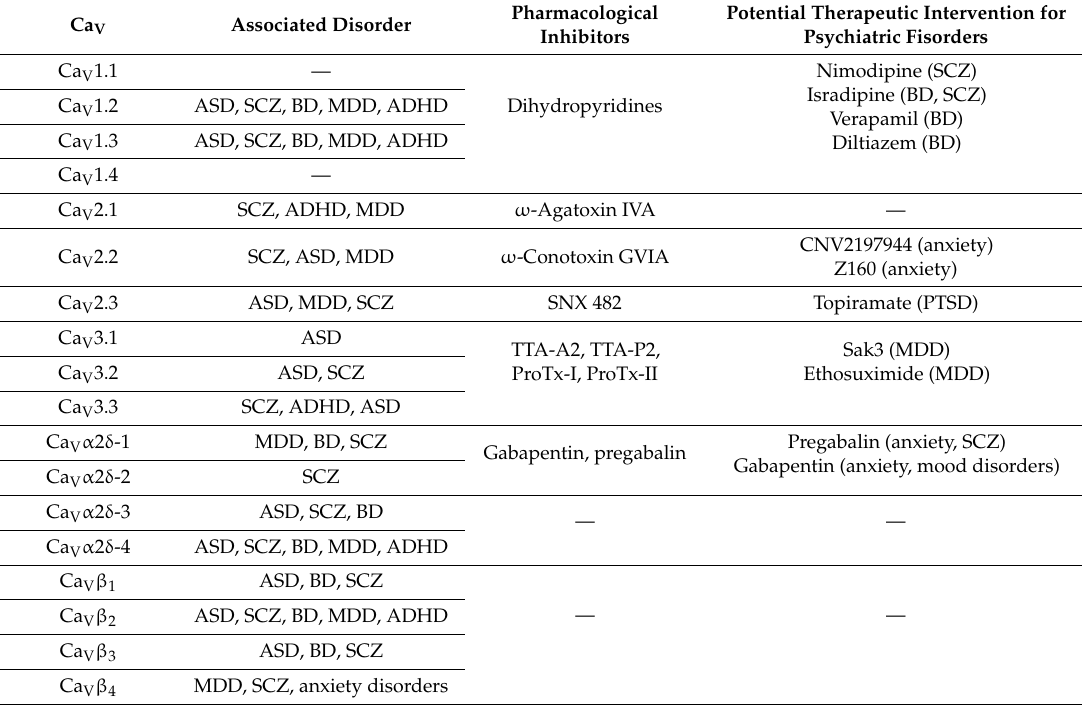
Table 2. Summary of genetic links between Ca V genes and psychiatric disorders, classical Ca V s, inhibitors and potential pharmacological strategies to treat psychiatric disorders using drugs that target Ca V s (drugs in clinical trials). — indicates that agents targeting this channel with potential use to treat psychiatric disorders are yet to be